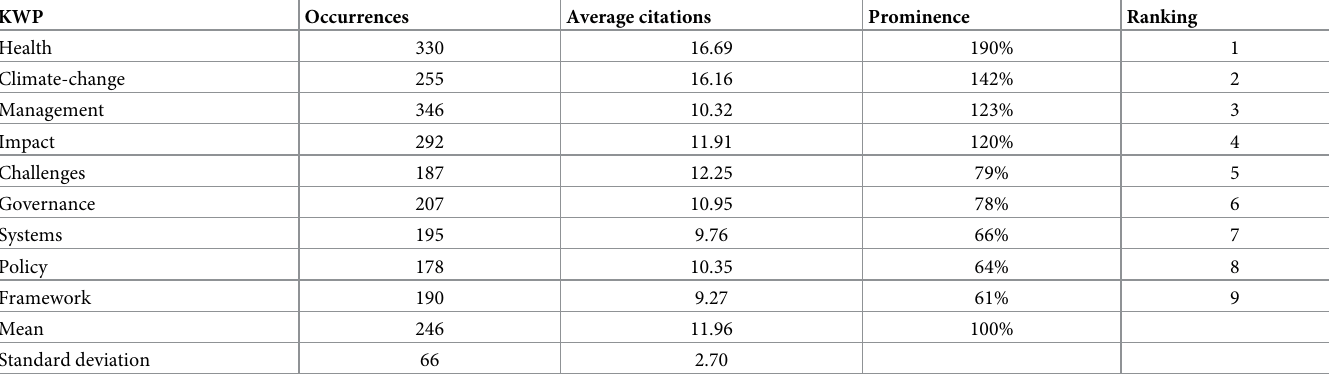
Table 5. Outstanding KWP in the